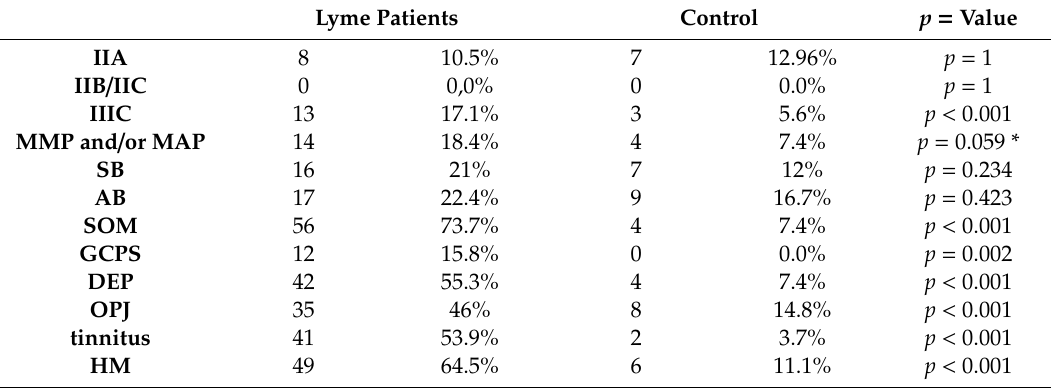
Frequency of the Research Diagnostic Criteria of Temporomandibular Disorders (RDC / TMD)-based diagnosed of temporomandibular joint (TMJ) status, function-dependent tests, and of Axis II findings including sleep bruxism (SB) and awake bruxism (AB) in Lyme patients and control